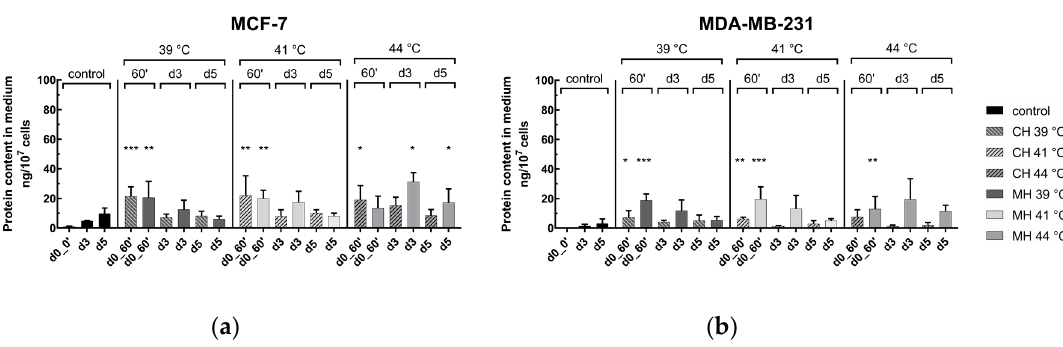
Figure 5. Analysis of danger signal HSP70 in the supernatant of ( a ) MCF-7 and ( b ) MDA-MB-231 breast cancer cells after conventional warm-water or microwave heating. Cells were heated either by conventional warm-water (CH) or microwaves (MH) within the self-designed hyperthermia system to three clinically relevant temperatures, i.e., 39 °C, 41 °C and 44 °C, for an effective time of 60 min (d0_0 ′ to d0_60). After the effective treatment time of 60 min, the cells were distributed into 75 cm 2 T-flasks for analysis on day 3 (d3) and day 5 (d5). The protein content of the danger signal HSP70 was analyzed by sandwich ELISA and is related to 1 × 10 7 cells. Mean ± S.D. are presented from at least three independent experiments, each measured in duplicates. Significance test was conducted using Kruskal-Wallis test with uncorrected Dunn´s multiple comparison, by comparing the protein content of the respective irradiation treatment to the corresponding controls of mock-treated cells at the indicated time points (d0_0 ′ , d3, d5). The exemplary shown controls of d0_0 ′ , d3 and d5 are from 39 °C and CH experiments and differ only slightly to other treatment controls; * ( p < 0.1), ** ( p < 0.01), *** ( p < 0.001).